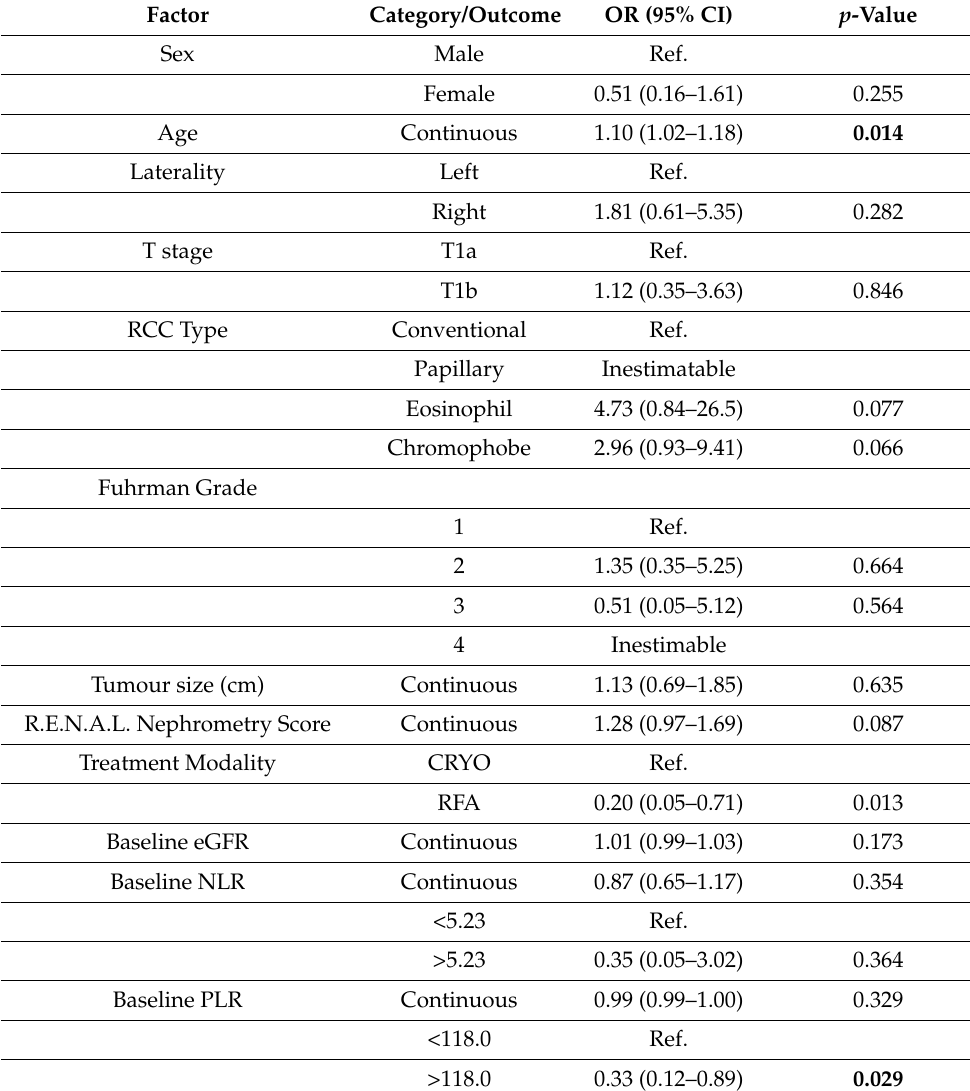
Table 11. Univariable analysis of prognostic factors associated with a larger than 25% drop in eGFR post-operatively.